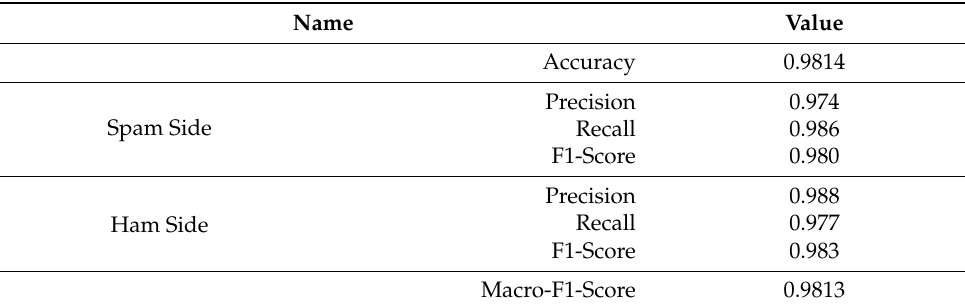
Table 9. Confusion matrix of classification results.